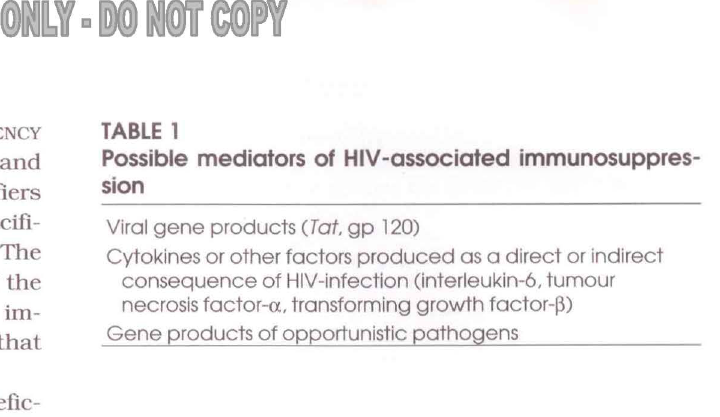
Possible mediators of HlV-associated immunosuppres